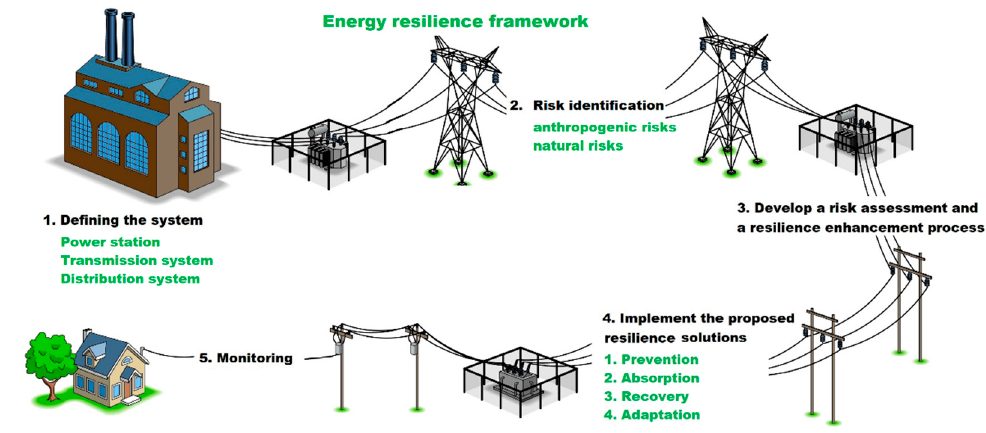
Figure 2. Energy resilience framework adapted according to [3].